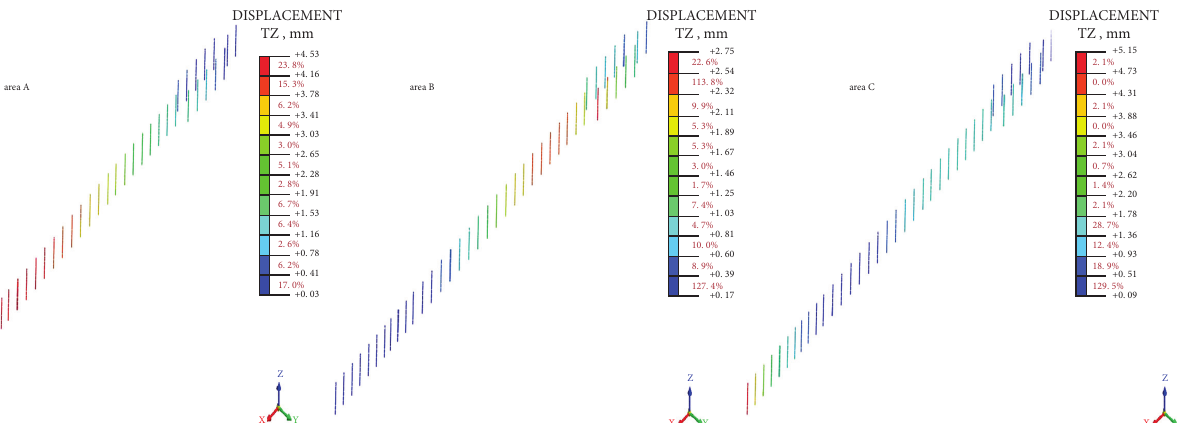
Figure 11: Vertical displacement of the station column from the foundation pit excavation to the pit bottom in each area.